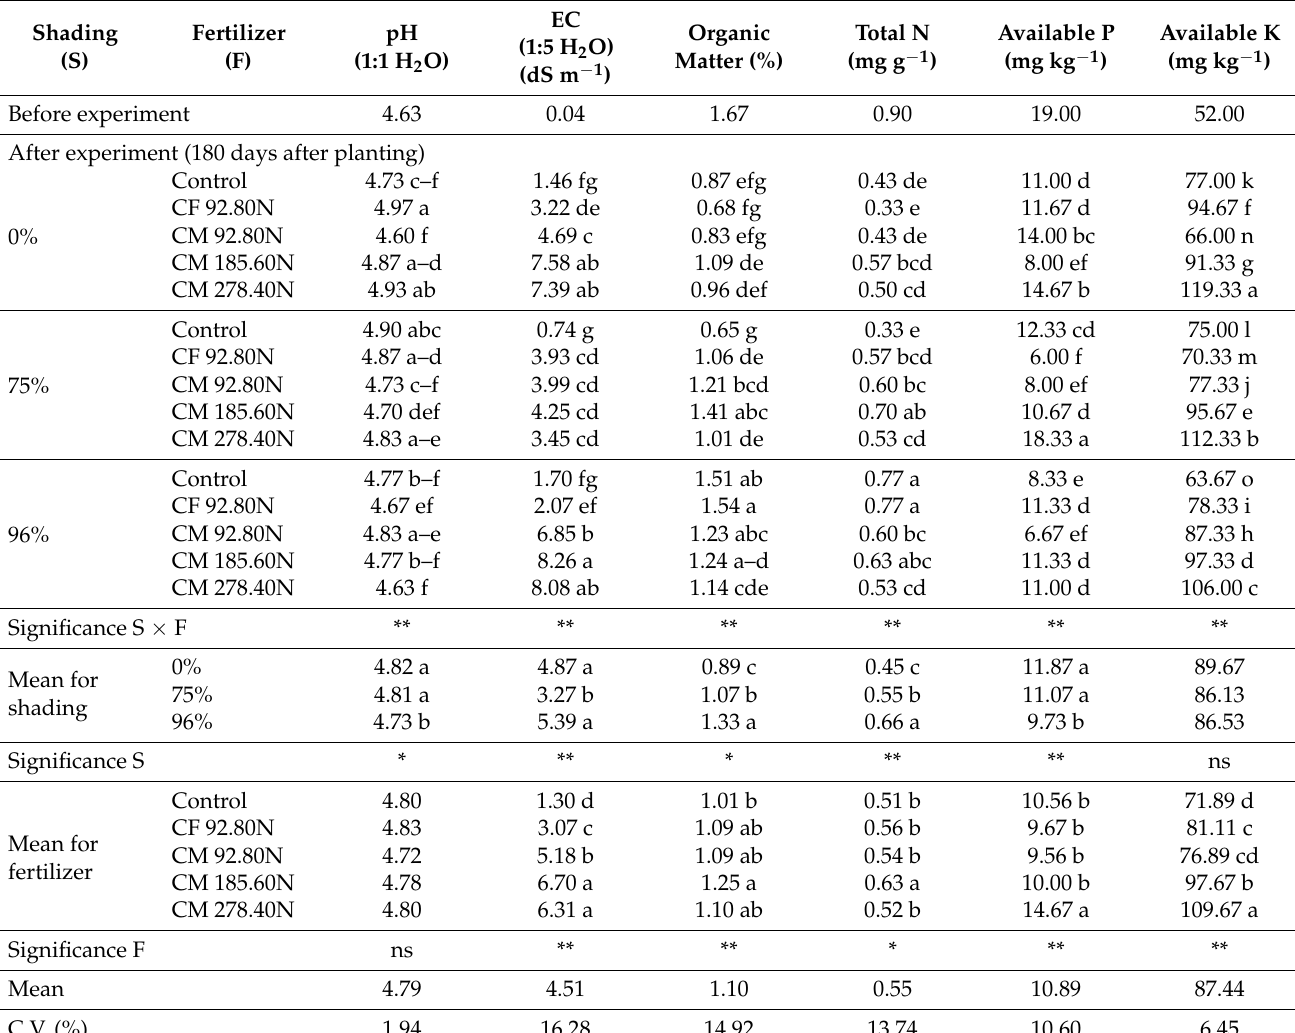
Table 2. Selected soil properties before and after